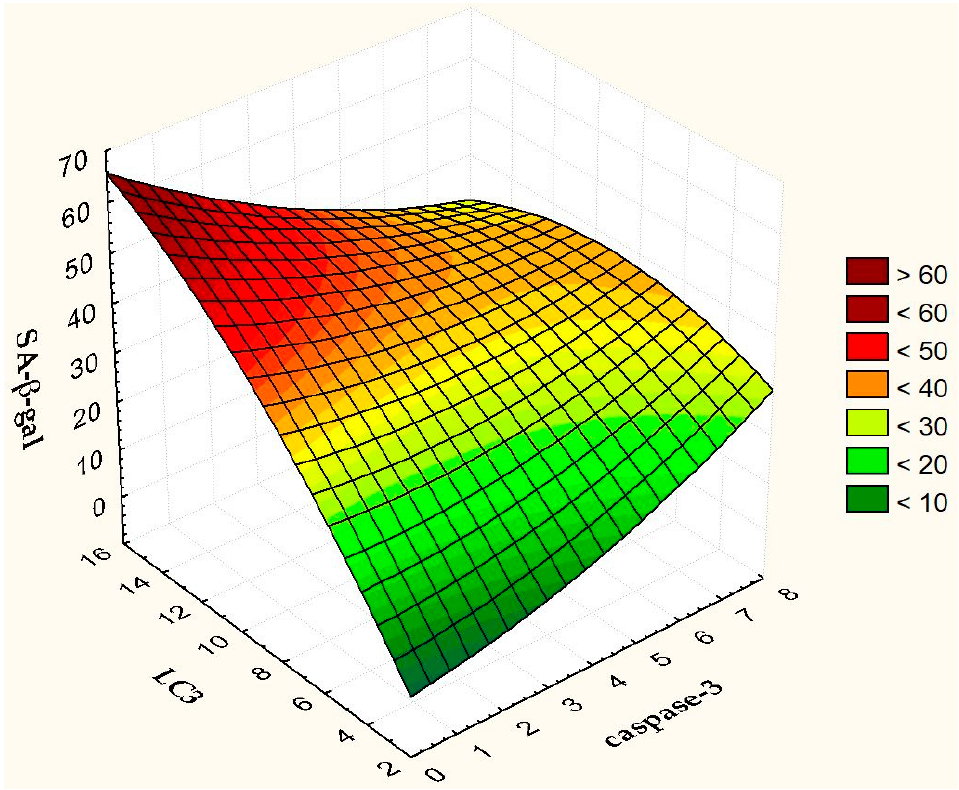
Figure 12. 3D Surface Plot of SA- β -gal against caspase-3 and LC3. Autophagy and apoptosis are known to cross-regulate each other through a com- plex network of relationships that also includes interactions between autophagy-related proteins and caspases [33]. A decrease in the activity of caspase-3, which is involved in the cleavage of various autophagy-related proteins (Atgs) [56], 48 h after irradiation, apparently promotes the process of autophagy. It is interesting that replicatively senes- cent fibroblasts are resistant to apoptotic death, associated with a lack of caspase-3 [57]. We have previously shown that the transcriptome of replicatively aged fibroblasts is similar to the transcriptome of the cells irradiated with 2 Gy [58]. Recent studies have shown that autophagy may conversely promote cellular senescence by facilitating the synthesis of secretory proteins associated with aging [59]. Autophagy is activated during senescence and its activation is correlated with negative feedback in the PI3K-mammalian target of rapamycin (mTOR) pathway [60]. The proportion of au- tophagic cells correlated with the proportion of senescent cells up to 72 h after irradia- tion. It is known that cell death, as well as senescence, are mechanisms of protection of normal cells from oncotransformation [61,62]. In the first case, severely damaged, poten- tially dangerous cells are eliminated, and in the second, they lose their ability to divide. Here natural questions arise. Why not eliminate all severely damaged cells? After all, senescent cells secrete senescence-associated phenotype factors that can amplify cellular senescence, alter the microenvironments, and even provoke oncogenesis [63,64]. Is there any biological sense in maintaining the viability of senescent cells? Recently, on the con-